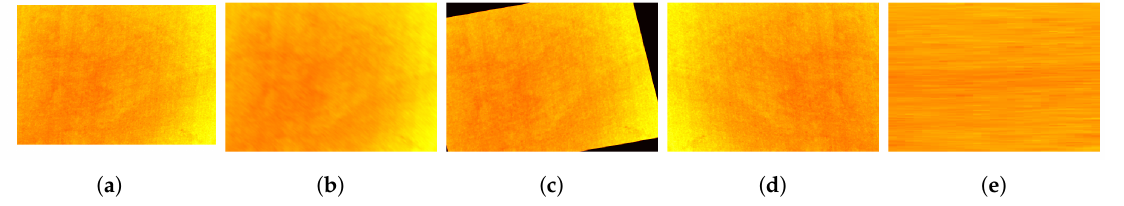
Figure 4. ( a ) Original thermal infrared image. ( b ) IR image with gaussian blur ( c ) IR image with affine transformation ( d ) IR image horizontally flipped ( e ) IR image